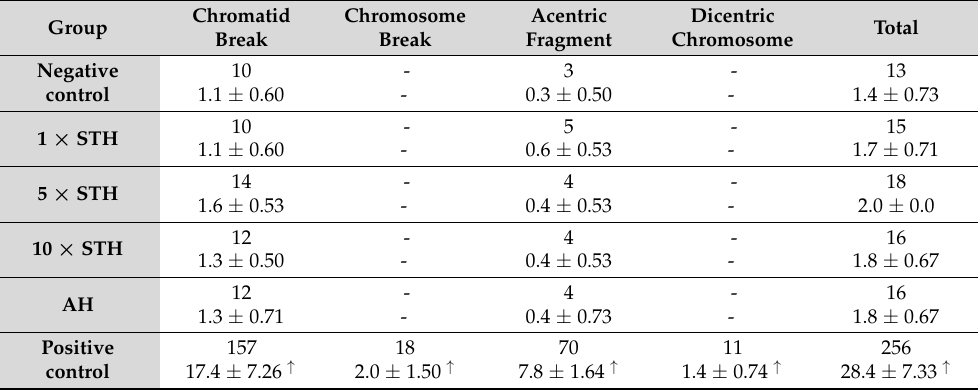
Data represent the sum (upper row) of CAs per experimental group, and their mean ± SD (lower row) based on nine independent scorings. Significantly increased ( p < 0.05) value is ↑ —vs. all other experimental